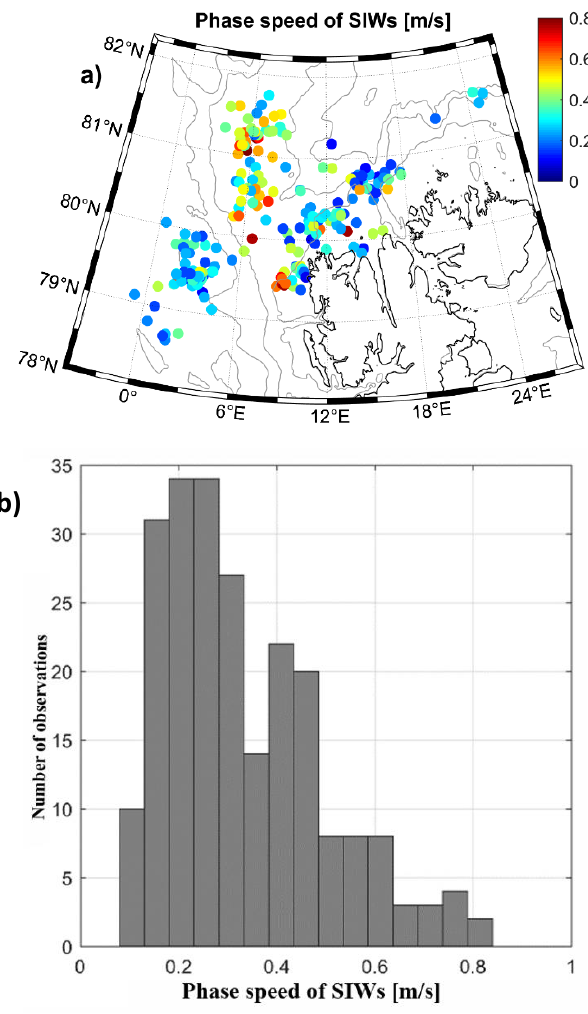
Figure 4 . Spatial map (a) and histogram distribution (b) of SIW phase speed values derived from sequential SAR observations in June-September